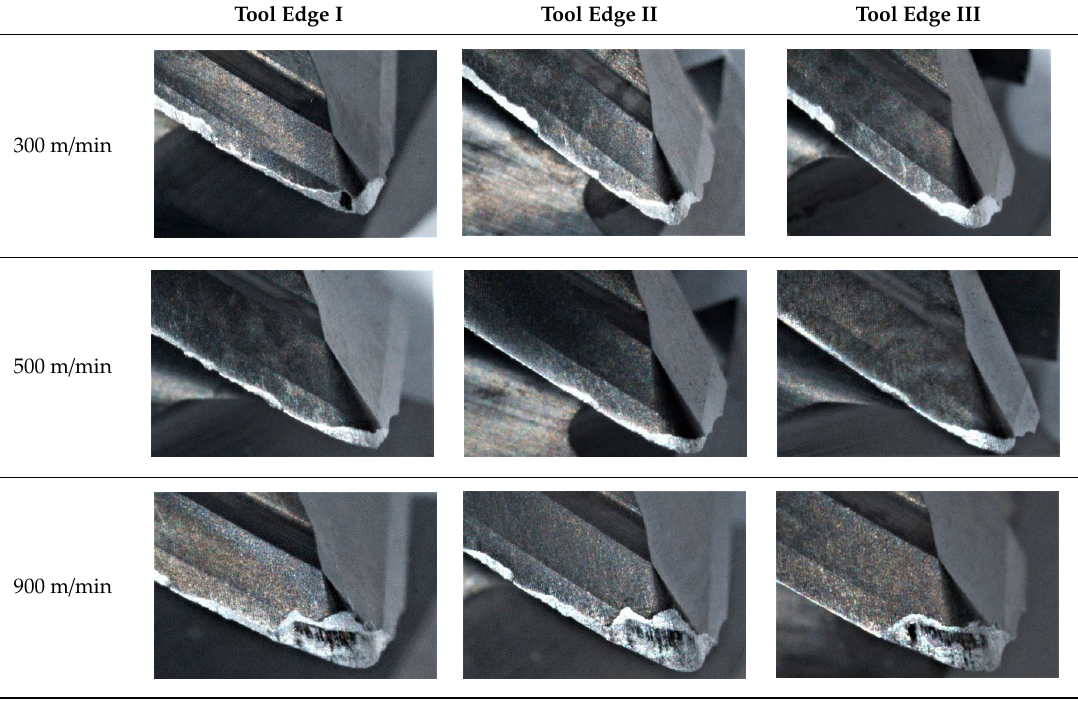
Table 7. State of tool corner wear VB C after milling with various cutting speed.